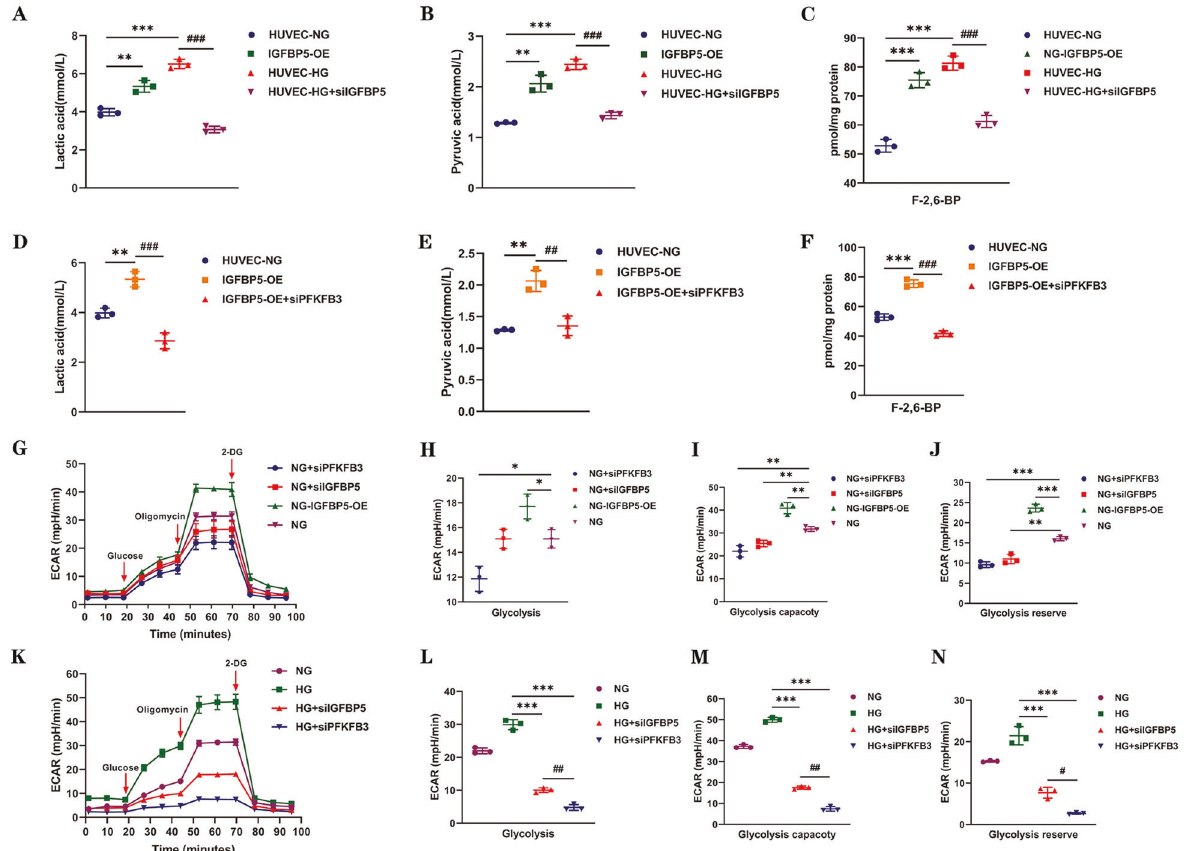
Fig. 4 IGFBP5 regulates glycolysis, which is required for endothelial cells, via PFKFB3. Four groups were created. IGFBP5-OE cells and control HUVECs were cultured under NG conditions. HUVECs were cultured in HG conditions and transfected with or without siIGFBP5. The levels of lactic acid ( A ), pyruvate ( B ), and F-2,6-BP ( C ) were measured in each group. n = 3. The levels of lactic acid ( D ), pyruvate ( E ), and F-2,6- BP ( F ) were measured in control and IGFBP5-OE cells that were transfected with or without siPFKFB3 under NG conditions. n = 3. G Glycolytic fl ux analysis of NG, NG + siPFKFB3, NG + siIGFBP5, and NG + IGFBP5-OE cells by a Seahorse Flux Analyzer. The extracellular acidi fi cation rate (ECAR) was recorded after the injection of glucose, oligomycin, and 2-deoxyglucose (2-DG). H – J Statistical analysis of glycolysis, the